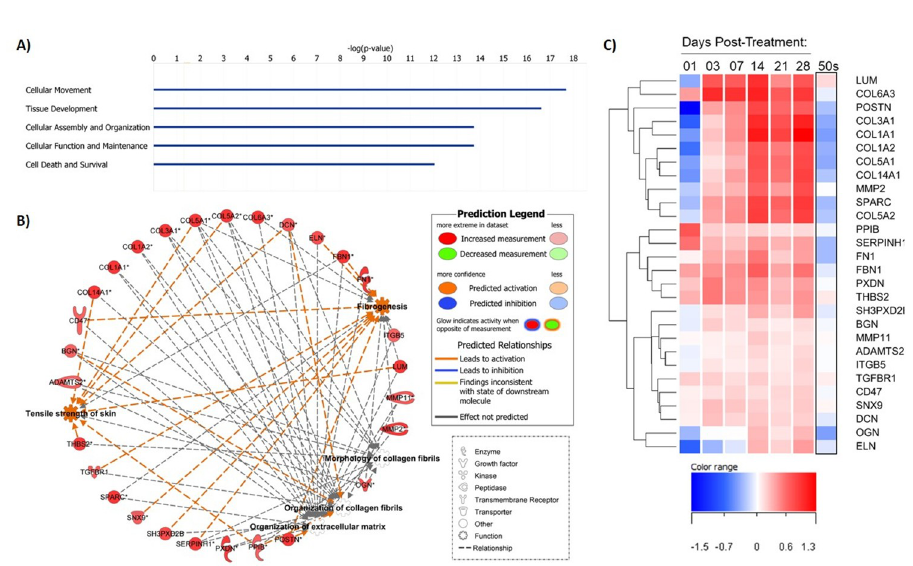
Fig 4. Activation of multiple collagen-related pathways by day 28 post-treatment. A) Bar chart showing top 5 molecular functions and system development processes associated with the day 28 gene signature (by–log 10 Fisher’s p- value). B) Network of shared genes across select collagen-related pathways associated with day 28 gene signature (from Table 6). C) Dendrogram displaying hierarchical clustering of shared collagen pathways across single laser resurfacing treatments (vs. baseline untreated samples) and in facial dermis of 50-year-olds vs. 20-year-olds described in Kimball et al., 2018, by log 2 fold change.